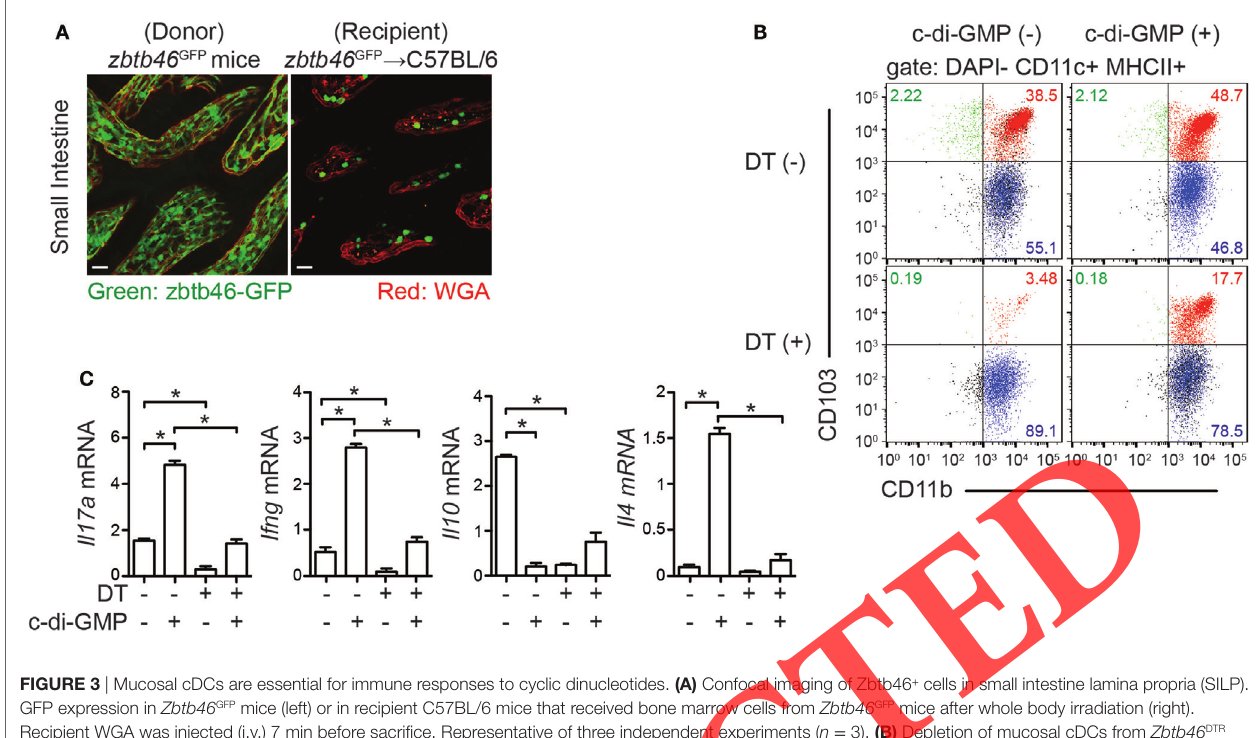
FigUre 3 | Mucosal cDCs are essential for immune responses to cyclic dinucleotides. (a) Confocal imaging of Zbtb46 + cells in small intestine lamina propria (SILP). GFP expression in Zbtb46 GFP mice (left) or in recipient C57BL/6 mice that received bone marrow cells from Zbtb46 GFP mice after whole body irradiation (right). Recipient WGA was injected (i.v.) 7 min before sacrifice. Representative of three independent experiments ( n = 3). (B) Depletion of mucosal cDCs from Zbtb46 DTR bone marrow chimeric mice. Recipient C57BL/6 mice received bone marrow cells from Zbtb46 DTR mice after whole body irradiation. DT was injected (i.p.) on day − 3 and day − 1, and c-di-GMP was injected (i.v.) 18 h before analysis. Representative of three independent experiments ( n = 3). (c) Fold change of Il17a , Ifng , Il10 , and Il4 gene expression in CD4 + T cells in Zbtb46 DTR bone marrow chimeric mice. Mice were prepared as described in panel (B) . CD3 + CD4 + T cells were isolated from SILP and were stimulated in vitro by anti-CD3 and anti-CD28 for 3 days ( n = 5). Abbreviations: DT, diphtheria toxin; WGA, wheat germ agglutinin; cDC, classical dendritic